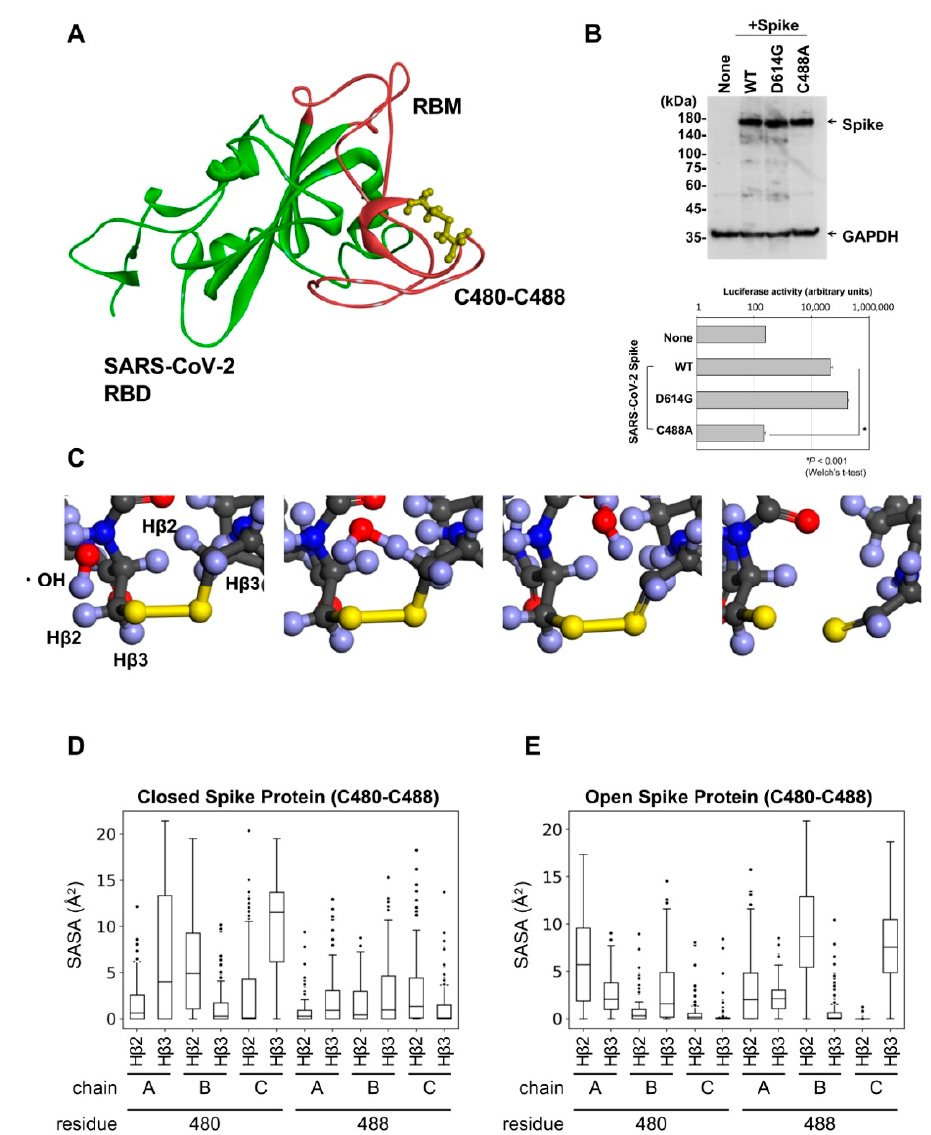
Figure 2. Disulfides bind with Cys480-Cys488 of SARS-CoV-2 spike RBM. ( A ) Three-dimensional structure of SARS-CoV-2 RBM colored in red. ( B ) Expression of Cys488A mutant spike proteins detected by Western blot analysis (upper panel). The infectivity of the pseudotyped viruses expressing each mutant spike protein were assessed by reporter luciferase activities in VeroE6/TMPRSS2 cells (lower panel). Data from triplicated samples were expressed as means ± SD. Statistical analysis was performed using Welch’s t -test. * indicates p < 0.001. ( C ) Using DFT calculation in Material Studio, hydroxyl radicals and six residues (Pro479-Cys480-Asn481, Asn487-Cys488-Tyr489) were reacted. ( D , E ) SASA (Å2) calculated on C β H atoms of each frame in MD simulation, which are next to disulfide-bonded sulfur.